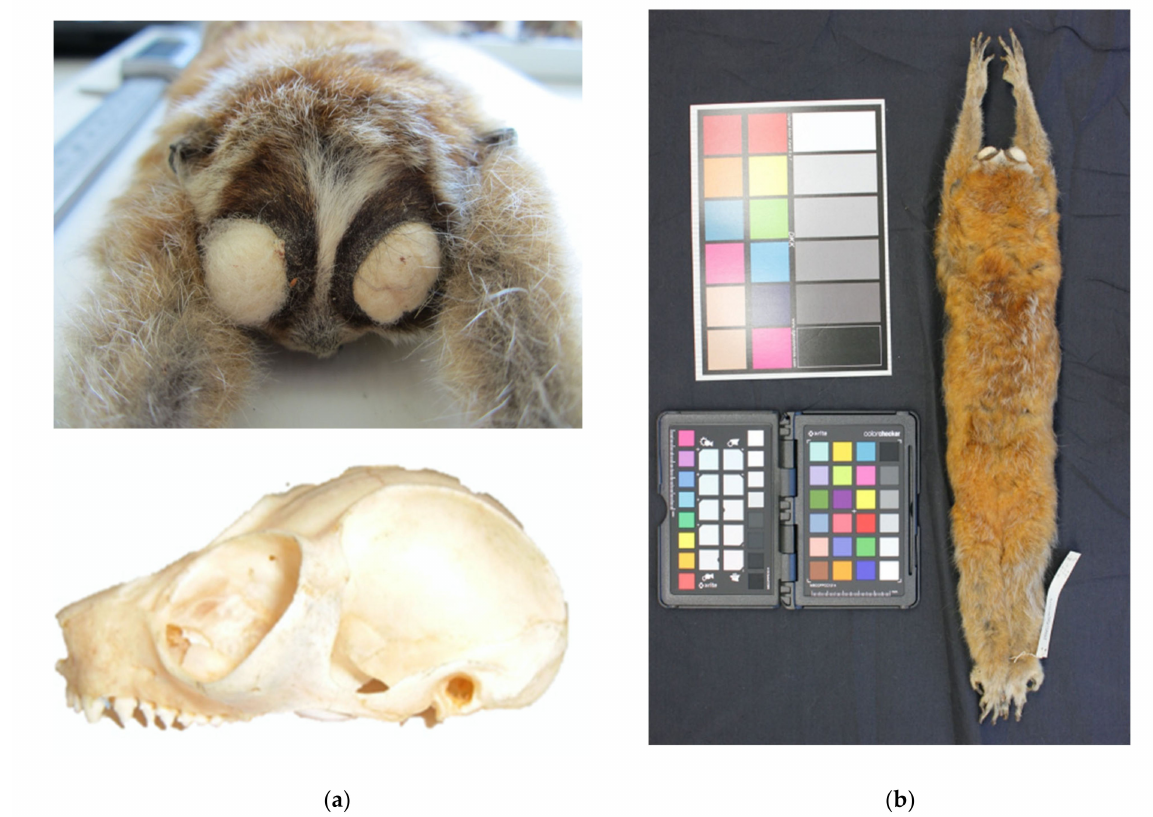
Figure 6. Xanthonycticebus intermedius specimen FMNH 32499: ( a ) Above: Facial mask (Photo by R. Munds), Below: Skull (Photo by K.A.I. Nekaris); ( b ) Full Dorsal View (Photo by M.